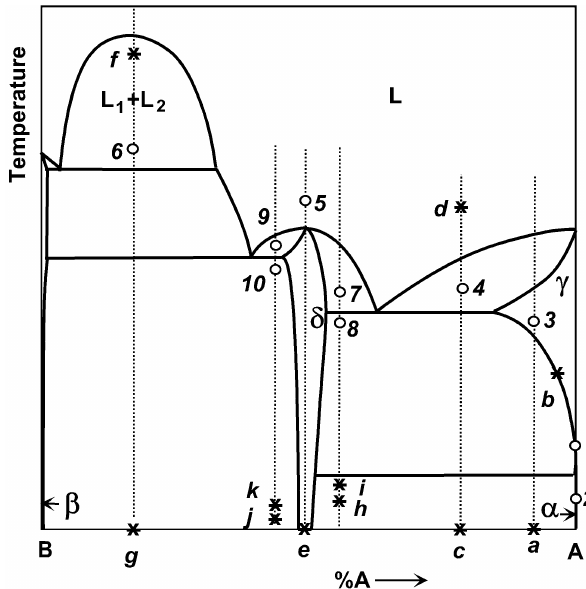
Figure 6. The schematic binary phase diagram showing the points of HPT deformation or other thermal treat- ments (stars) and respective configuration points at the (increased) effective temperatures. Other explanations are in the